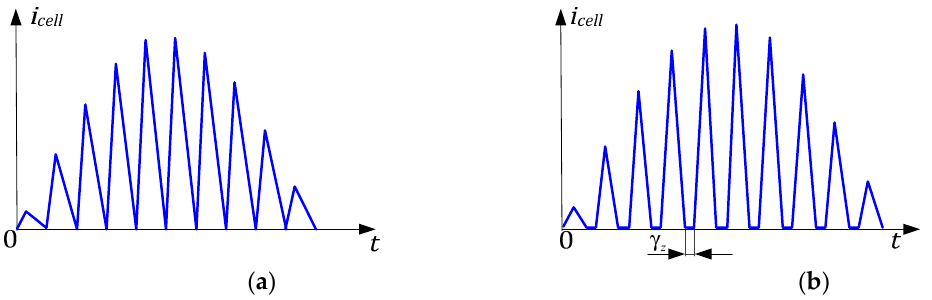
Figure 10. Input current shape of a cell: ( a ) Boundary conducting mode; ( b ) discontinuous conducting mode with zero current interval γ z .